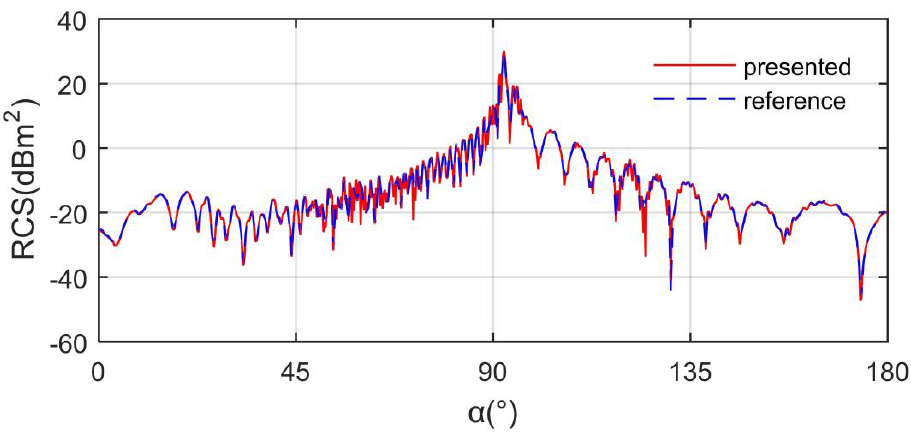
Figure 4. Verification of the RCS calculation: X t = 0.1 m; F rh = 6 GHz; β = 0 ° .